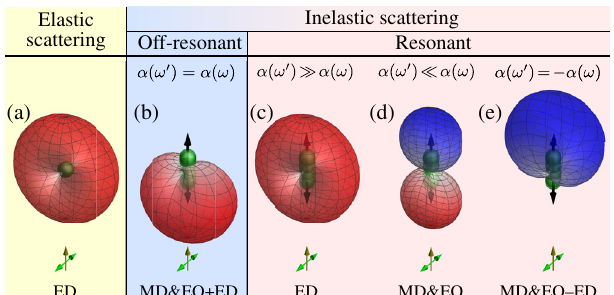
FIG. 3. Radiation pattern for (a) elastic light scattering and (b) – (e) inelastic scattering by a trembling particle for different ratios of the polarizabilities at initial and scattered frequencies α ð ω Þ and α ð ω 0 Þ . The interference of the electric dipole (c) and magnetic dipole and electric quadrupole (d) patterns results in directional inelastic forward (e) and backward (b) scattering. The light is incident from the bottom (yellow arrow) and is linearly polarized (green arrow), the particle trembles along the light propagation direction (black arrow). Red and blue colors indicate the sign of electric